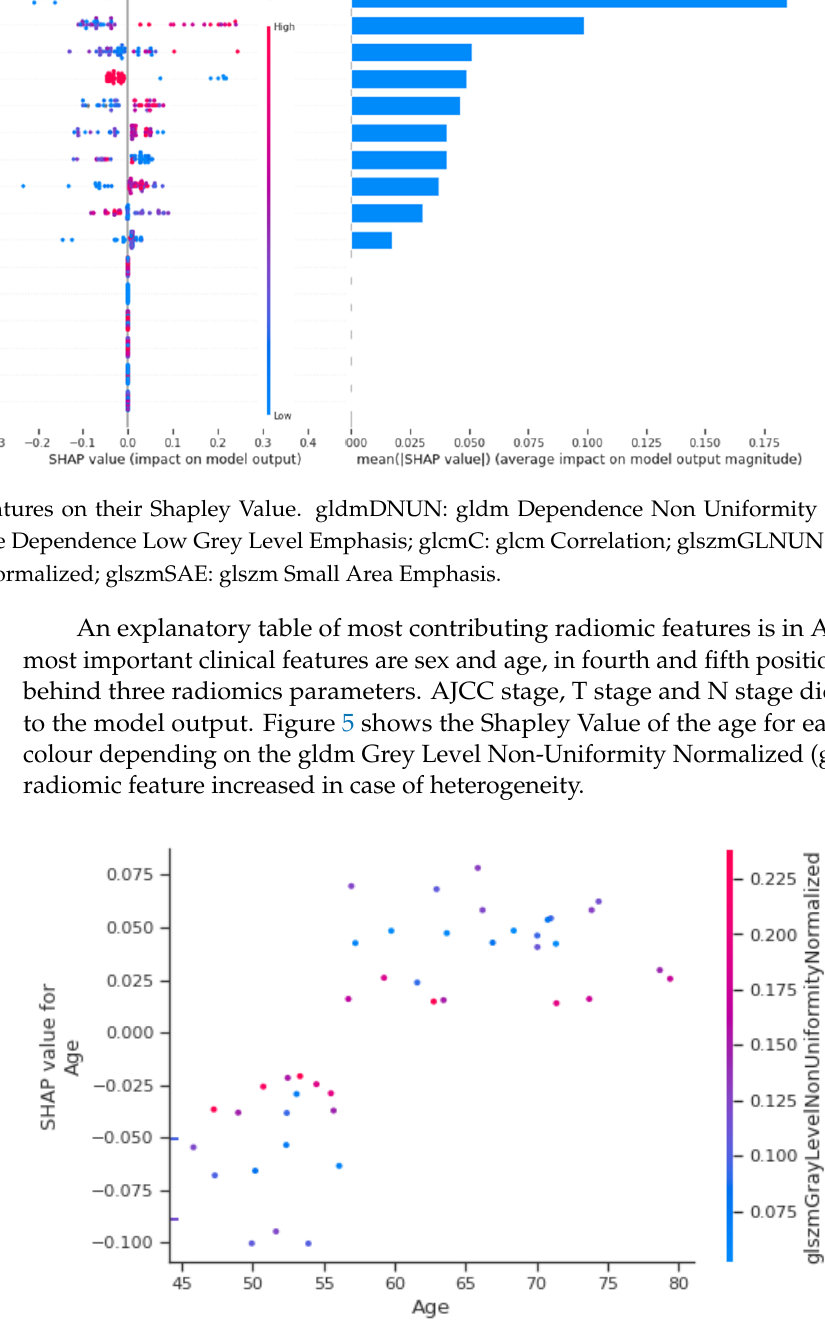
Figure 5. Shapley Value depending on age for each patient.